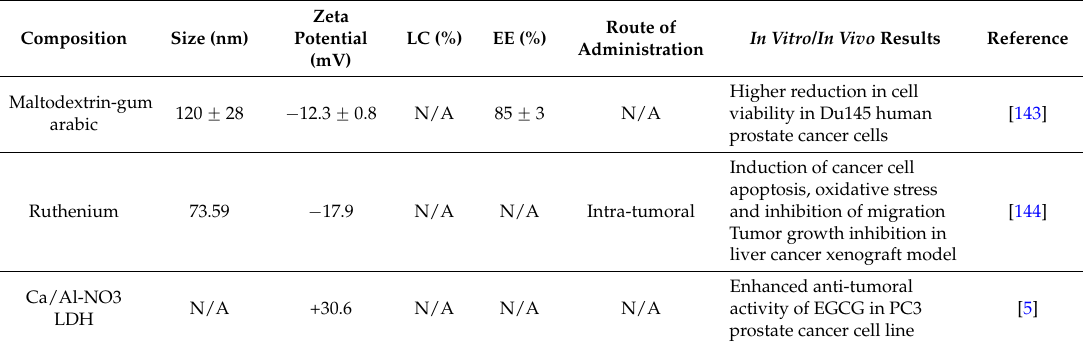
Table 4. Nanoparticles designed with various materials used as EGCG nanocarriers for cancer therapy.